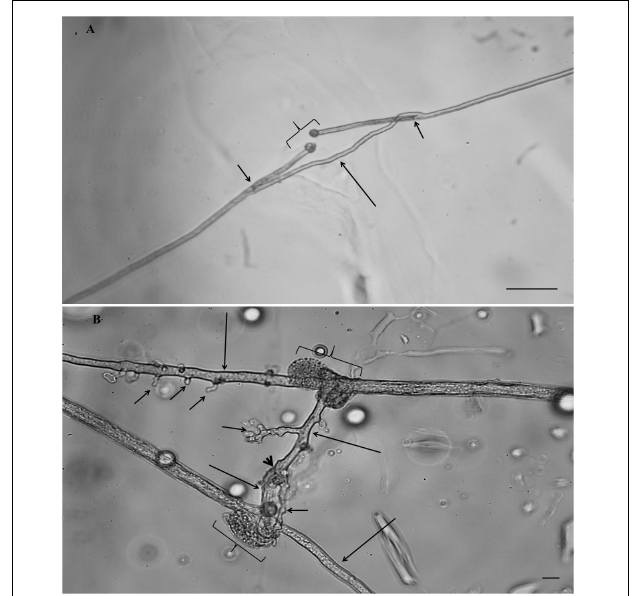
FIGURE 1 | Hyphal healing mechanism (HHM) of AM fungi in the control treatment (A) Gigaspora sp. MUCL 52331, the plugs were formed at both extremities in front of the hyphal injury (braces), two growing hyphal tips (GHTs) emerged at both extremities behind the septum (short arrows) and fused (large arrow) with re-establishment of cytoplasmic/protoplasmic flow (scale bar 50 µ m). (B) Rhizophagus irregularis MUCL 41833, the plugs were formed at both extremities in front of the hyphal injury (braces), two GHTs from each injury site emerged through the septum (large arrows) and one GHT of each side contacted and fused (arrowhead) with re-establishment of cytoplasmic/protoplasmic flow. Several hyphal branches (short arrows) developed from the GHTs (scale bar 10 µ